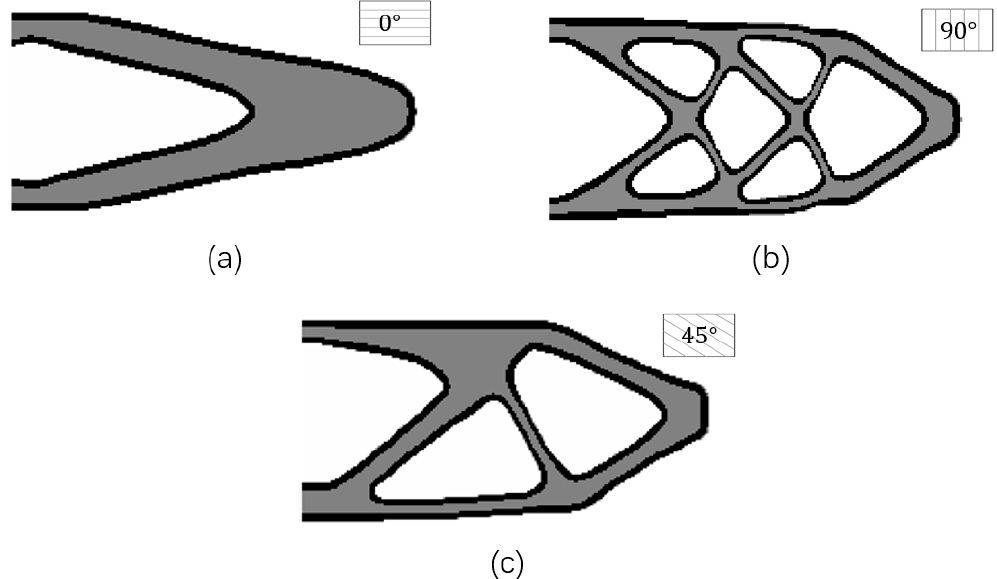
Figure 14. The optimized results with different raster directions: ( a ) 𝜃 = 0° , 𝑐 = 36.9816 ; ( b ) 𝜃 = 90° , 𝑐 = 52.7019 ; ( c ) 𝜃 = 45° , 𝑐 = 42.0721 .